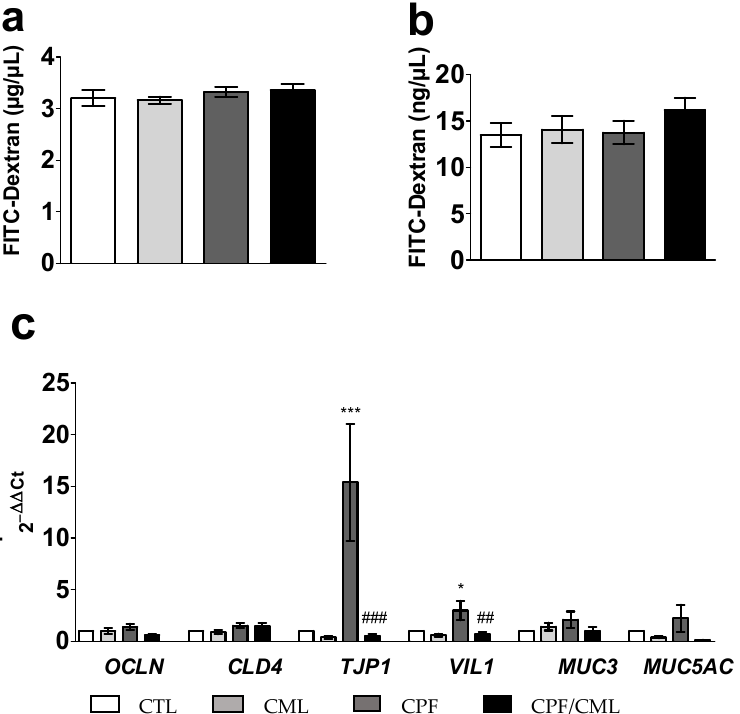
Figure 3. Effect of a 6 h incubation with CML (300 μM) and/or CPF (300 μM) on the level of FITC-Dextran in apical ( a ) and basal ( b ) media, and of the relative mRNA expression of genes coding for tight junctions and mucins measured by qPCR from the Caco-2/TC7 and HT29-MTX co-culture ( c ). Data are expressed as the mean ± SEM ( n = 12). The level of gene expression was expressed as the fold induction over the CTL group set at 1. *, *** statistically significant difference ( p < 0.05; p < 0.001 CPF vs. CTL); ##, ### statistically significant difference ( p < 0.01; p < 0.001 CPF/CML vs. CPF). CML, N ε - Carboxymethyllysine; CPF, Chlorpyrifos; CTL, control; CLDN4 , Claudin 4; MUC3 , Mucin 3; MUC5AC , Mucin 5AC; OCLN , Occludin; TJP1 , tight junction protein 1; VIL1 , Villin